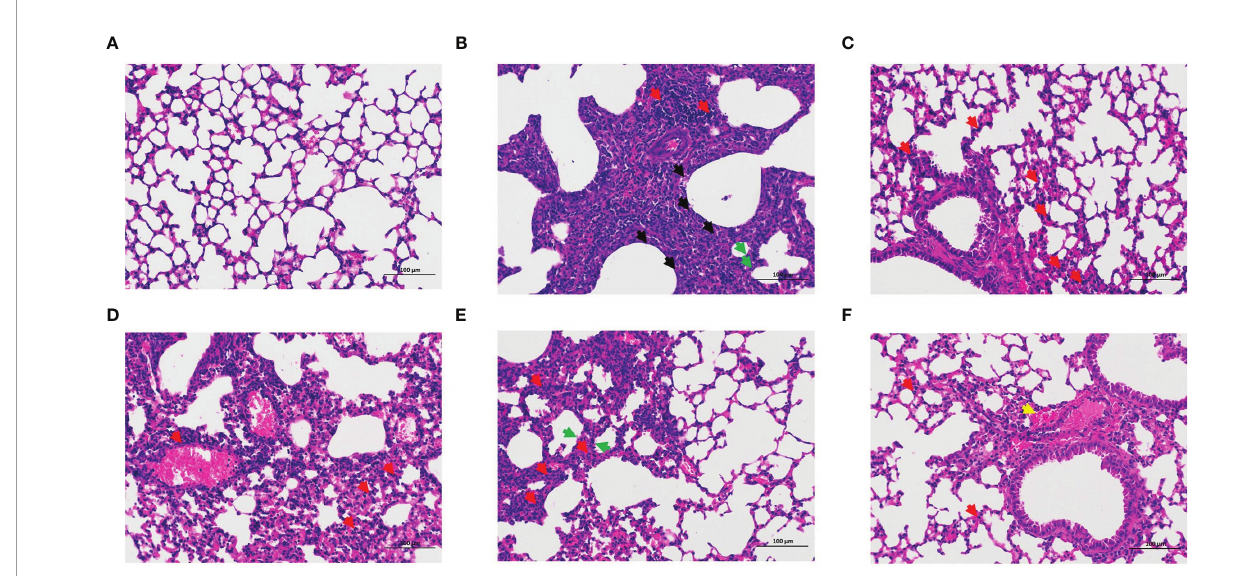
FIGURE 3 | Pathological observation of the lung in mice. Lung pathological changes were observed by HE staining at 5 dpi (200 x): control group (A) , model group (B) , oseltamivir group (C) , LNT-L group (D) , LNT-M group (E) , and LNT-H group (F) . Necrosis of epithelial cells (black arrow); In fl ammatory cell in fi ltration (red arrow); Alveolar wall thickening (green arrow); Bleeding (yellow